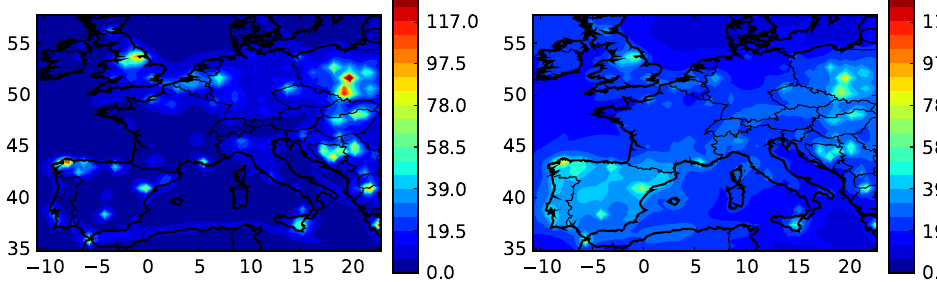
Fig. 10. Temporal average of SO 2 map for reference model 5 (left) and for model 88 of the 101-member ensemble (right).